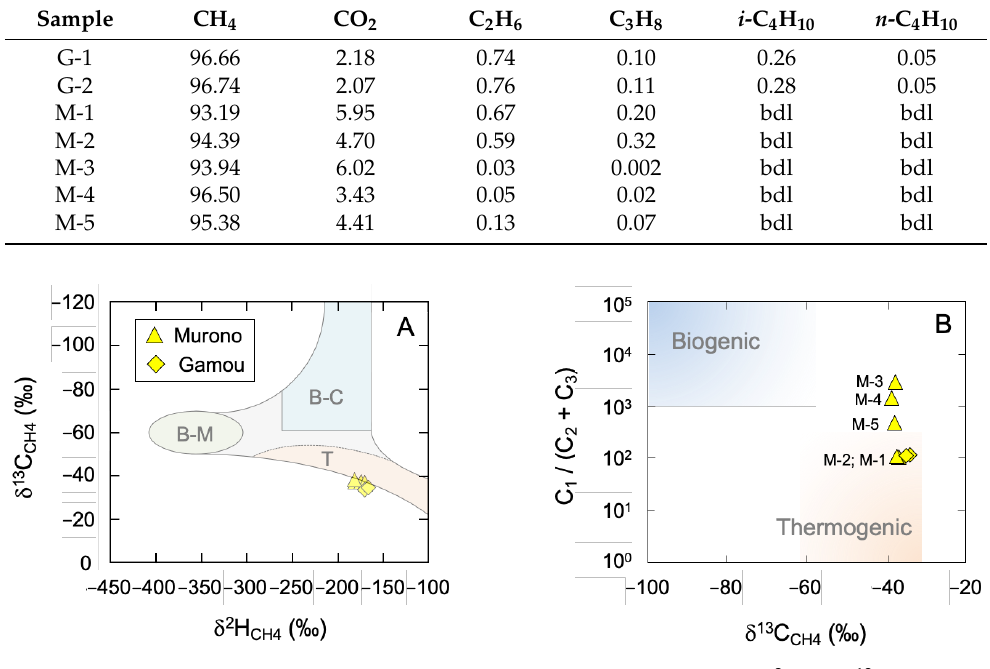
Figure 3. Conventional diagrams for the diagnosis of methane sources: ( A ) δ 2 H vs. δ 13 C (“Schoell diagram”) ( B ) δ 13 C vs. C 1 / (C 2 + C 3 ) (“Bernard plot”). “T”: Thermogenic; “B-M”: Biogenic